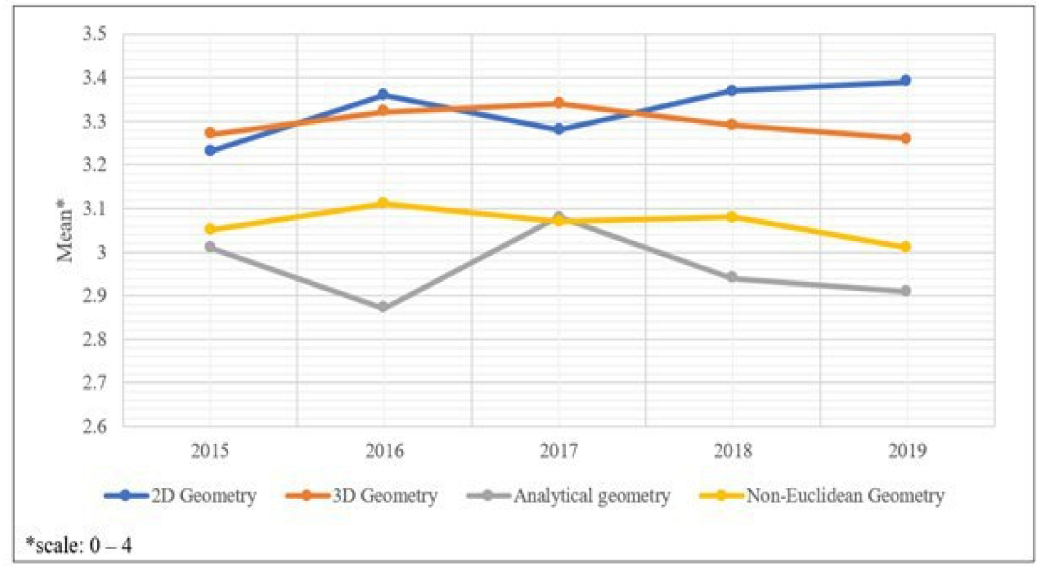
Figure 1. Average geometry scores